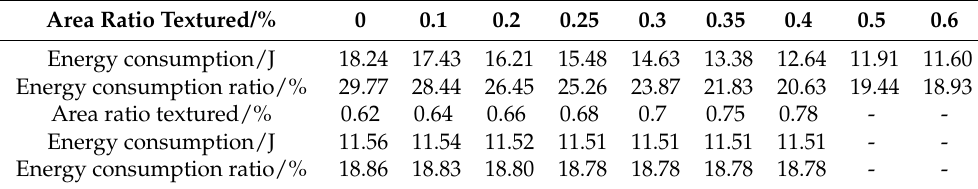
Figure 11. Energy consumption ratio with different area ratio textured. Table 1. Energy consumption and its ratio in one cycle with different area ratio textured.